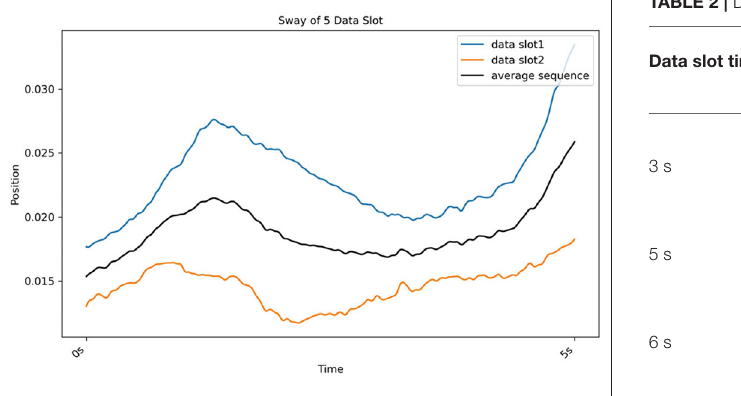
FIGURE 7 | Results of DBA, which gradually determines the average sequence (black line) of two sequences (red line from CH2 and blue line from CH3).